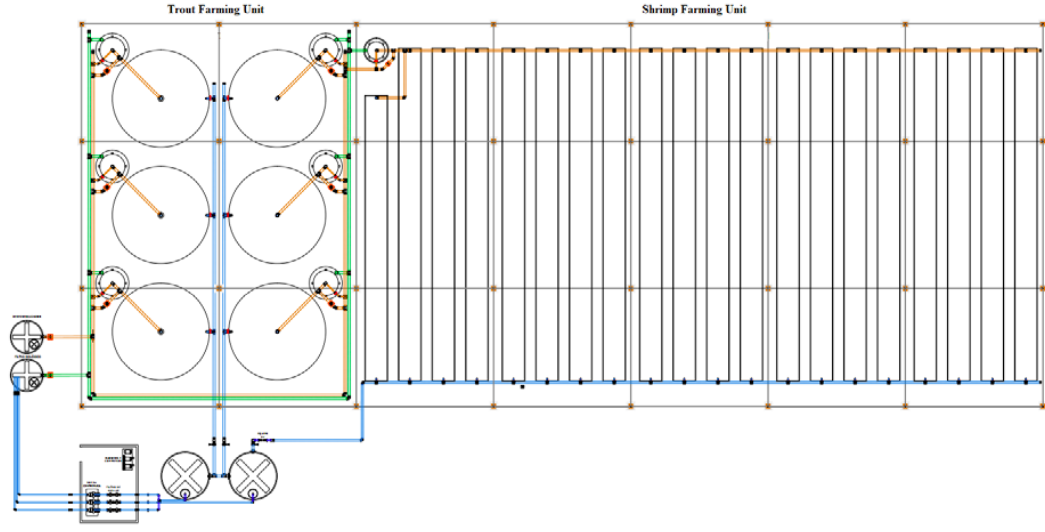
Figure 5. Aquaculture recirculation system scheme (proper elaboration).